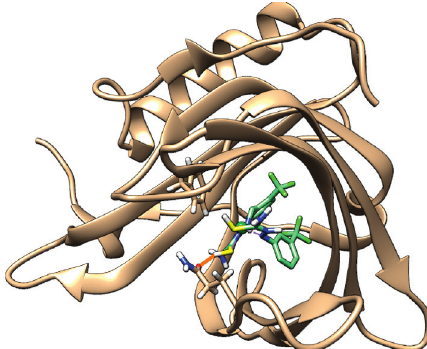
Figure 8: Molecular docking studies of NiL